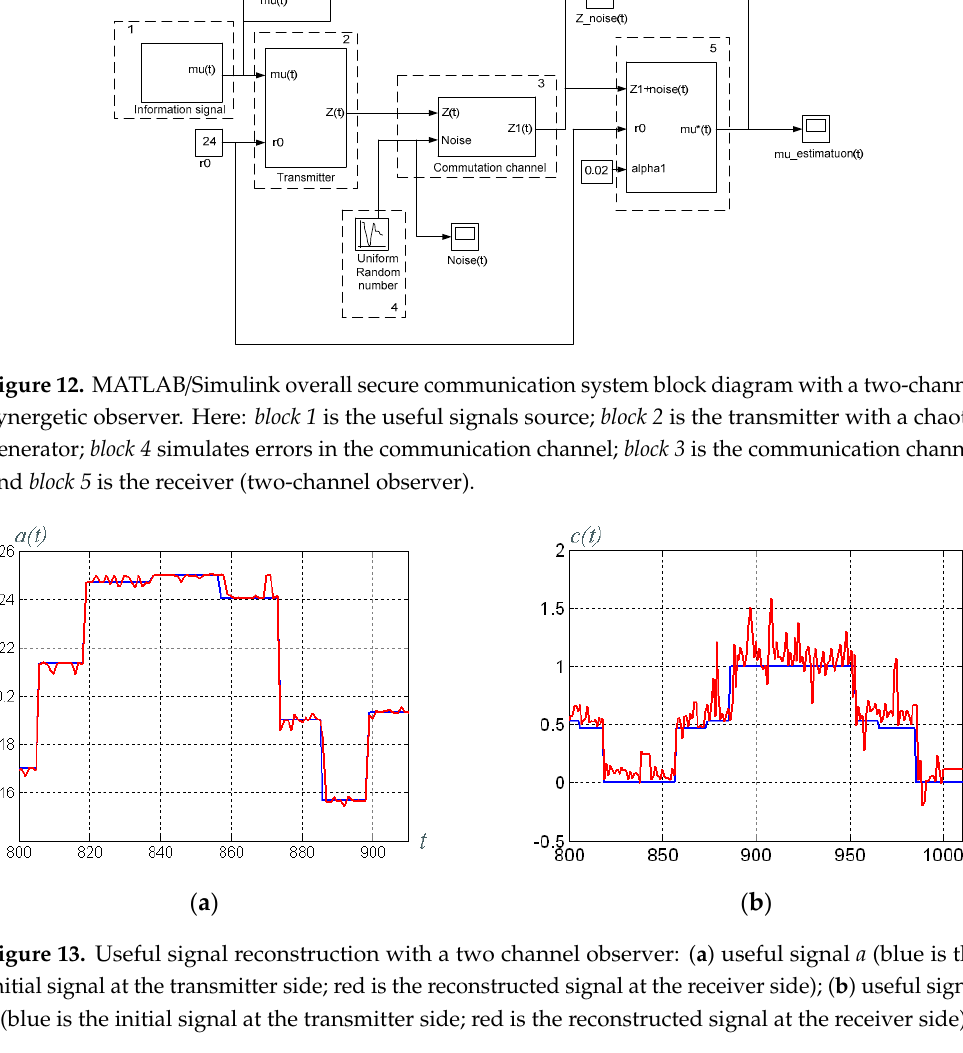
Figure 13. Useful signal reconstruction with a two channel observer: ( a ) useful signal a (blue is the initial signal at the transmitter side; red is the reconstructed signal at the receiver side); ( b ) useful signal c (blue is the initial signal at the transmitter side; red is the reconstructed signal at the receiver side).